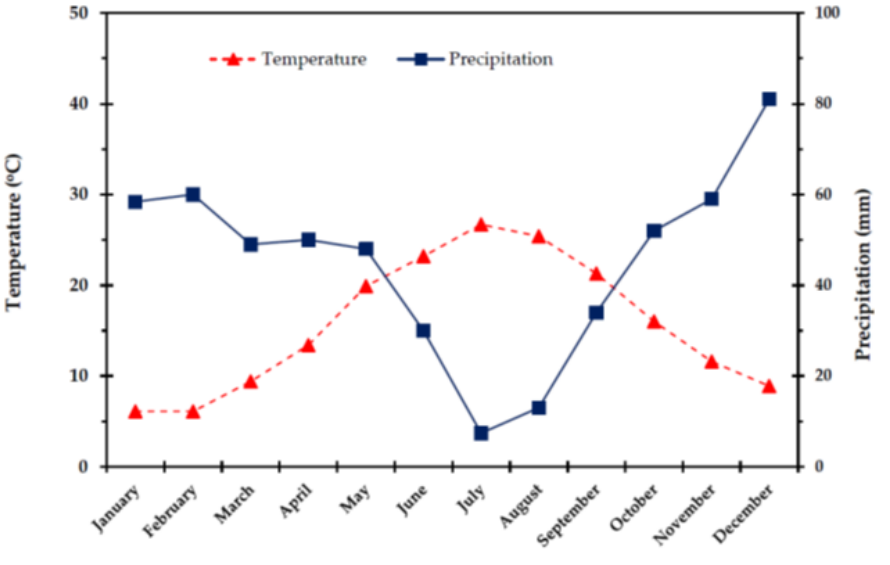
Figure 9. Ombrothermic diagram in the study area throughout a year.